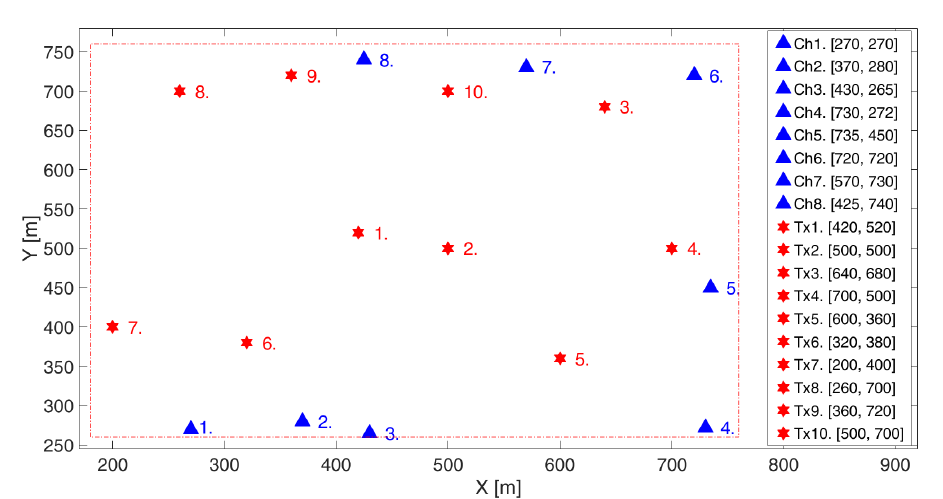
Figure 8. The constellation of the microphone array and multiple impulse sound sources.